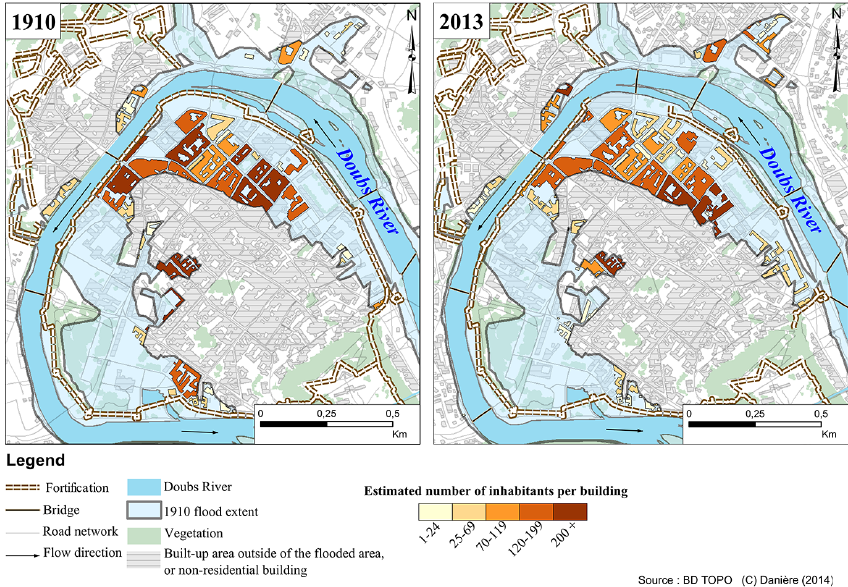
Figure 9. Estimated number of inhabitants per building within the area affected by the 1910 flood in Besançon: (a) in 1911 and (b) in 2013. Some blocks of houses are depicted only on one of the maps, because of land-use changes. Non-residential blocks of houses are not taken into account